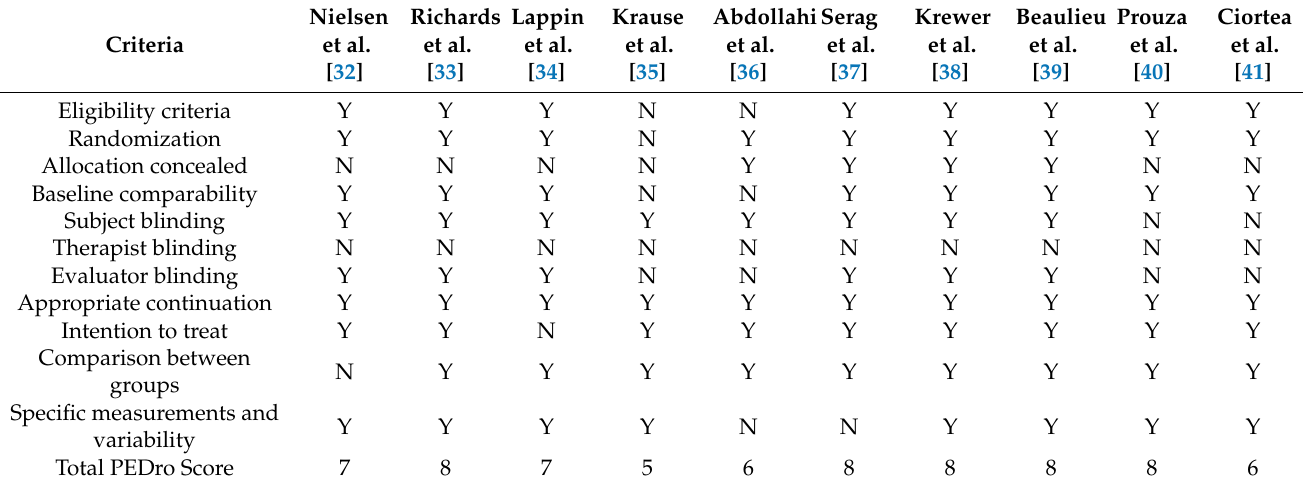
Table 3. Methodological quality assessment (PEDro